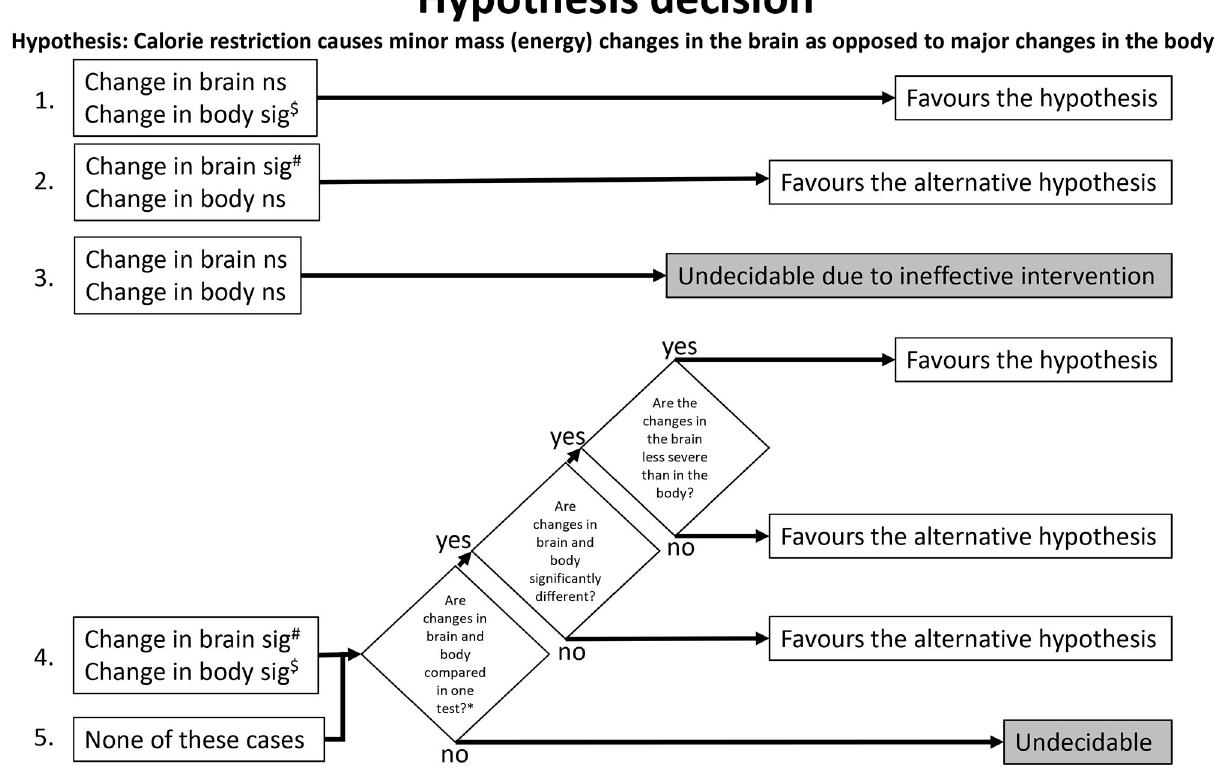
Frontiers in Neuroscience |